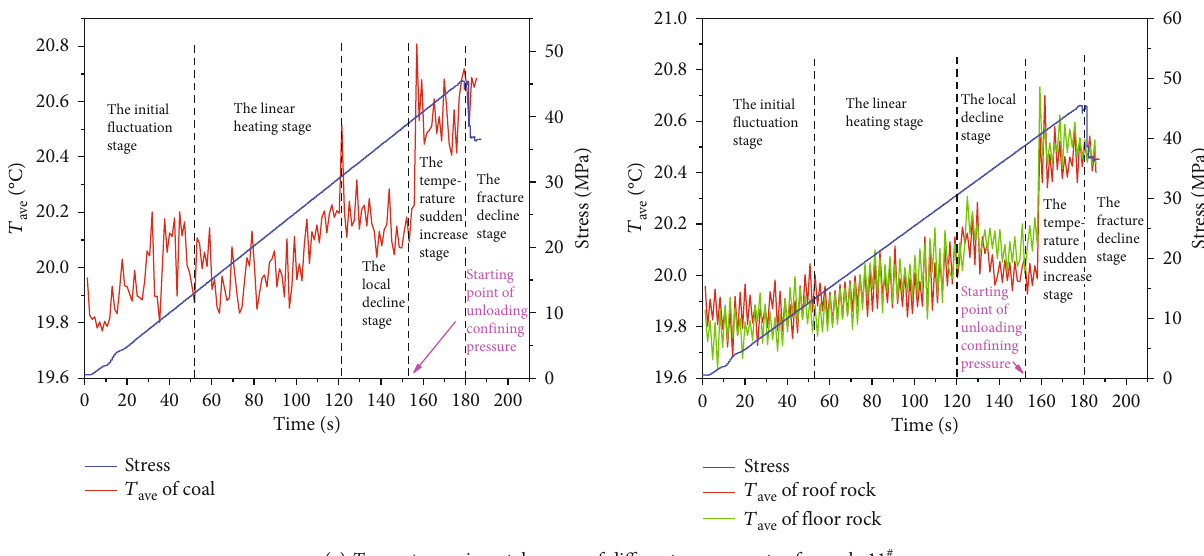
σ - t experimental curves of di ff erent components of composite coal-rock. Among them, (a), (b), and (c) are the T Figure 10: T ave - experimental curves of the samples 1 # , 6 # , and 11 # at the unloading con fi ning pressure rate of 0.003MPa/s, 0.03MPa/s, and 0.05MPa/s, respectively.